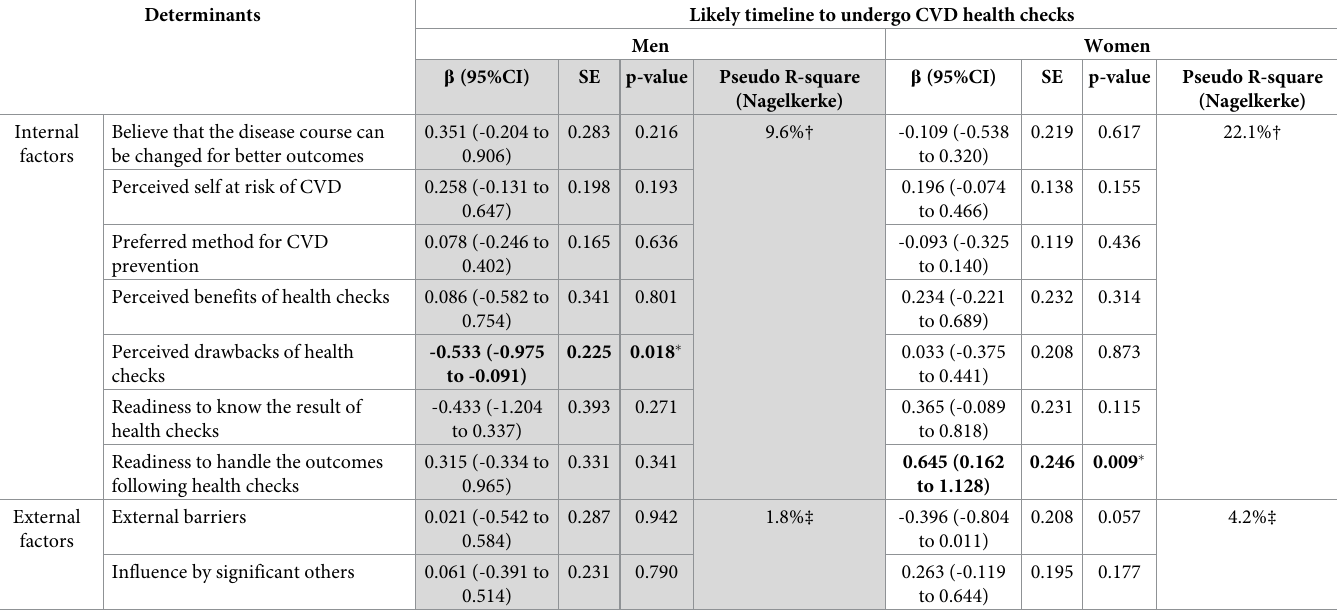
Table 4. Determinants of individuals’ likely timeline to undergo CVD health